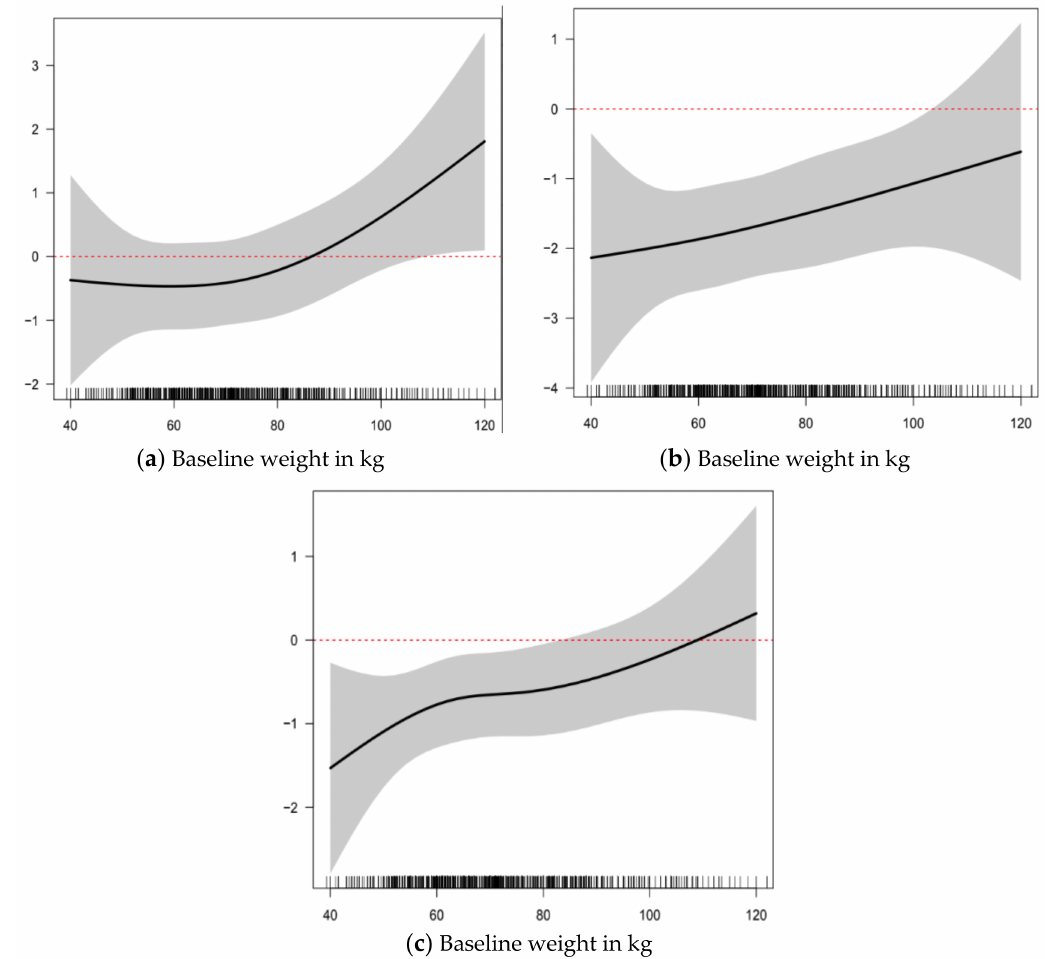
Figure 3. Two-year Percentage Changes in areal Bone Mineral Density (BMD 95% CI) in Relationship to Baseline Weight; Percent change in: ( a ) Lumbar Spine (L1-4); ( b ) Femoral Neck; and ( c ) Total Hip in Women ages 43–63 in the Canadian Multicentre Osteoporosis Study (CaM os ) (n =